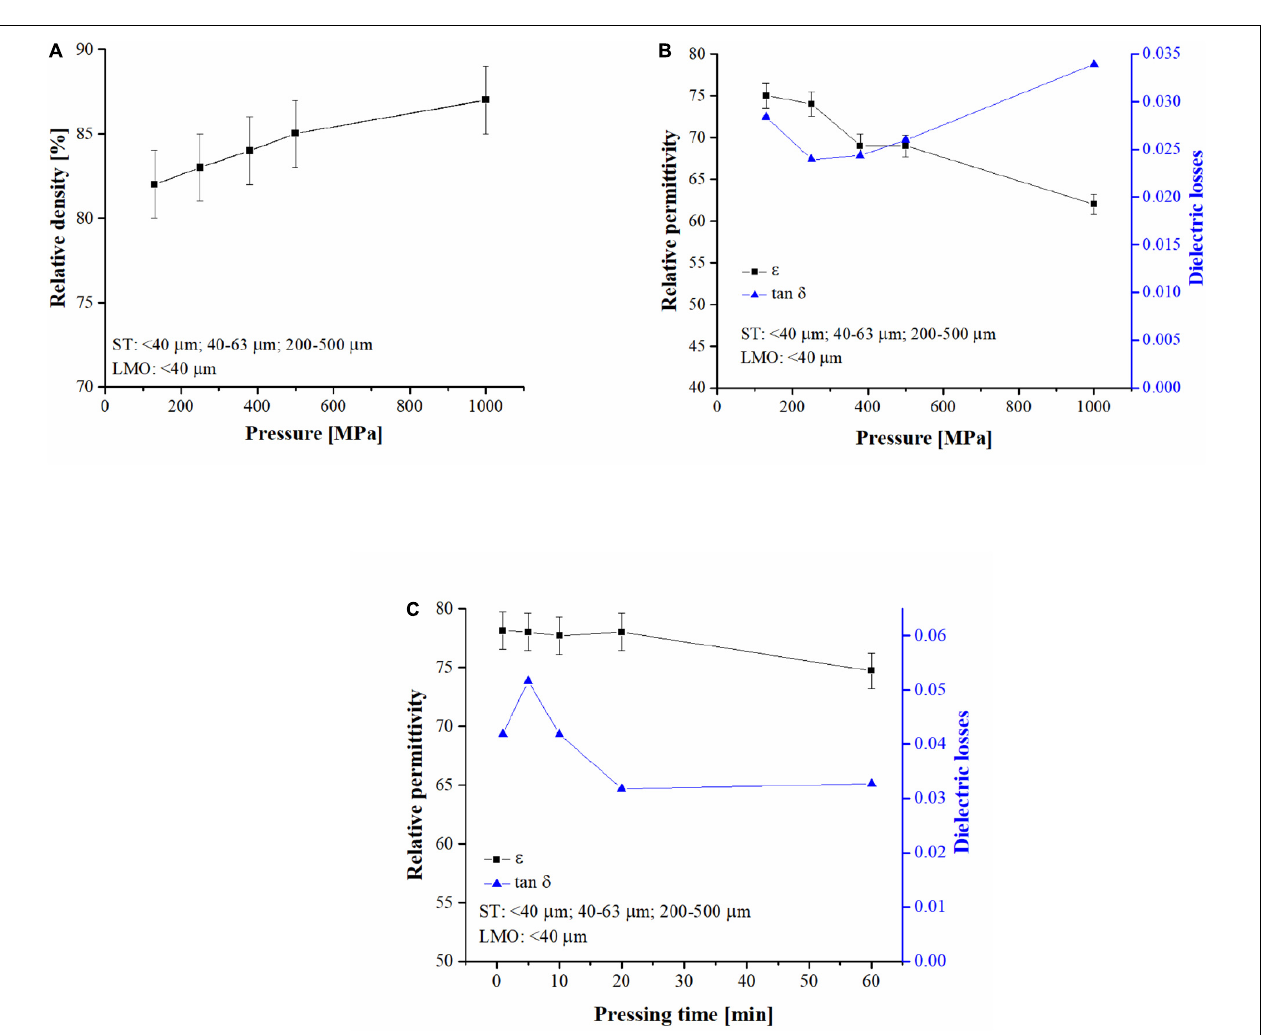
FIGURE 8 | (A) The effect of pressure on relative density of LMO-ST composites. (B) The effect of pressure on relative permittivity and dielectric losses of LMO-ST composites. (C) The effect of pressing time on relative permittivity and dielectric losses of the LMO-ST composites.